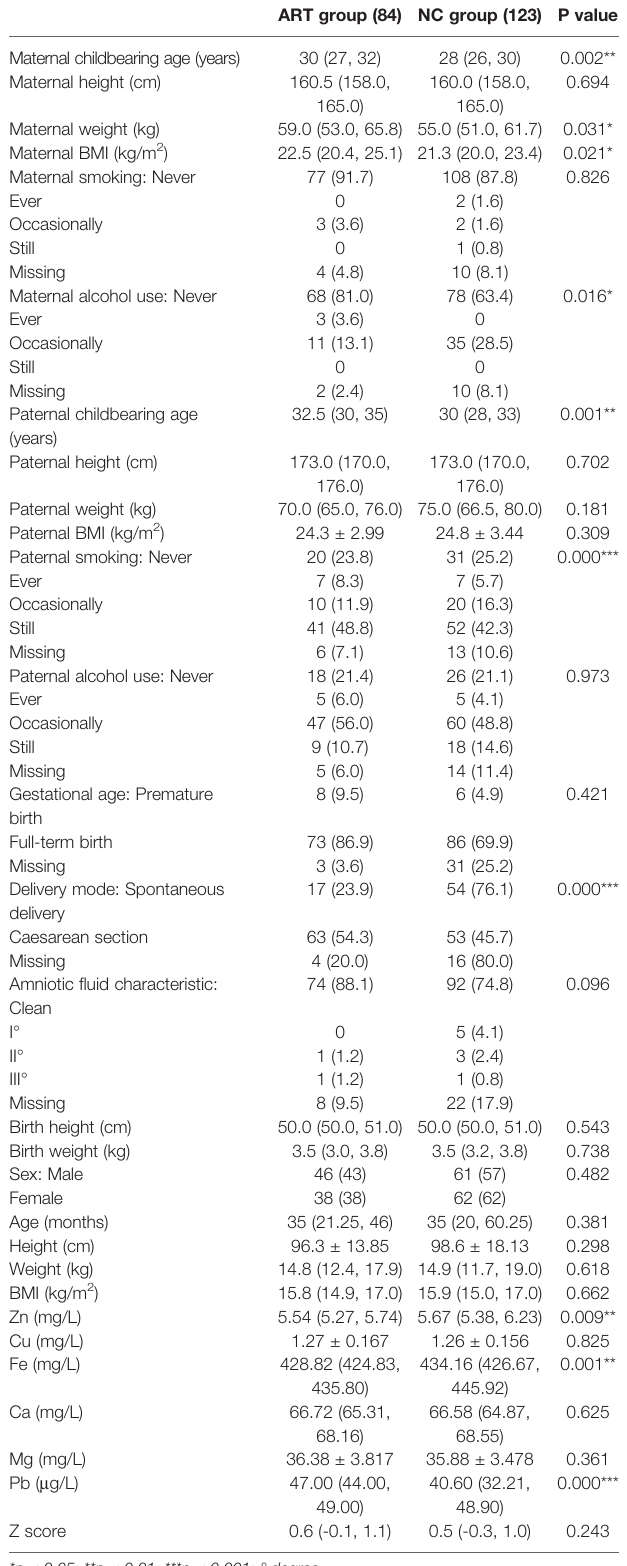
TABLE 1 | Single-factor analysis of bone mineral density-related